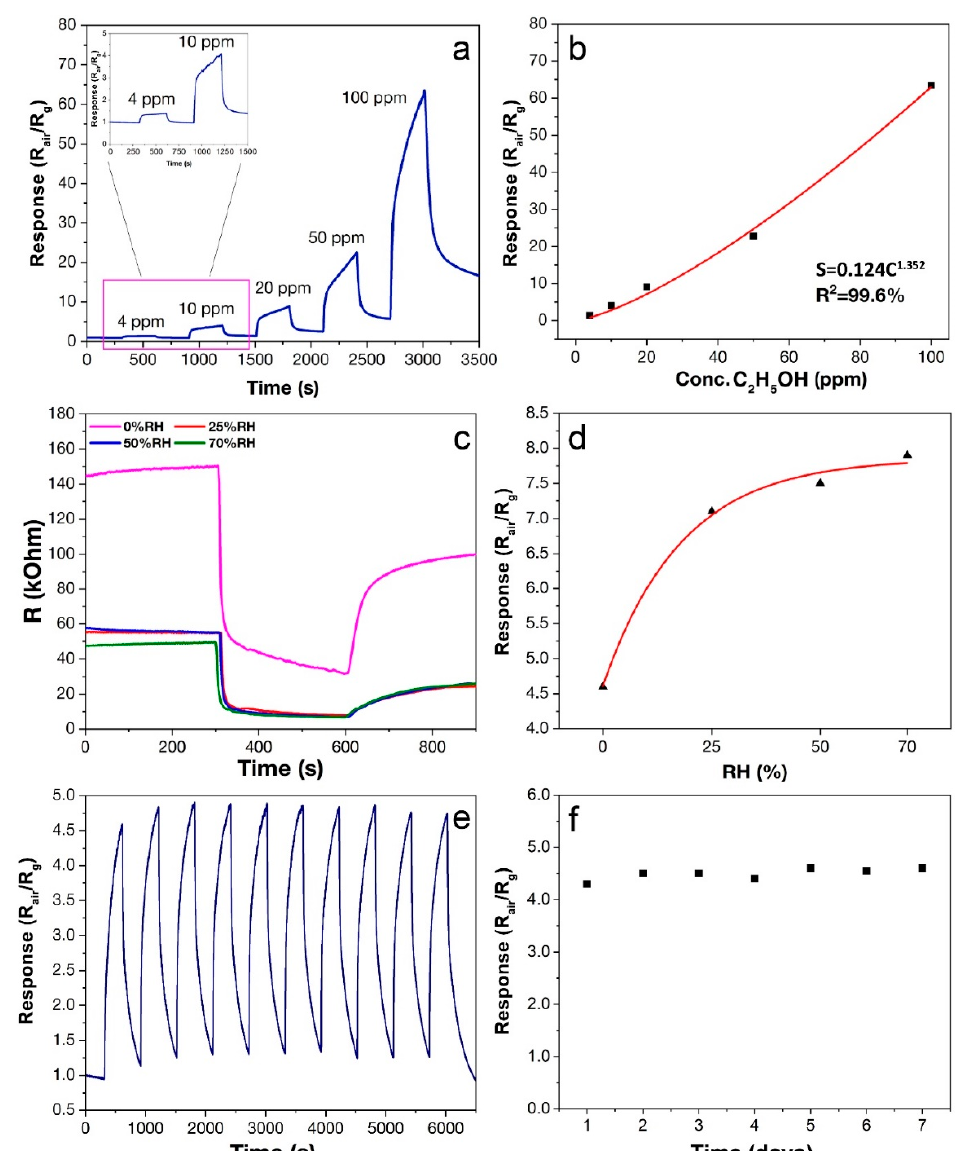
Figure 9. Dependence of the sensor response on the concentration (4–100 ppm) of C 2 H 5 OH ( a , b ), change of resistance upon detection of 10 ppm C 2 H 5 OH at 0–70% RH ( c ) and dependence of the response on 10 ppm C 2 H 5 OH at different humidity ( d ), signal reproducibility when detecting 10 ppm C 2 H 5 OH ( e ) and long-term stability of the SnO 2 thick film ( f ). The operating temperature in all cases was 200 °C.